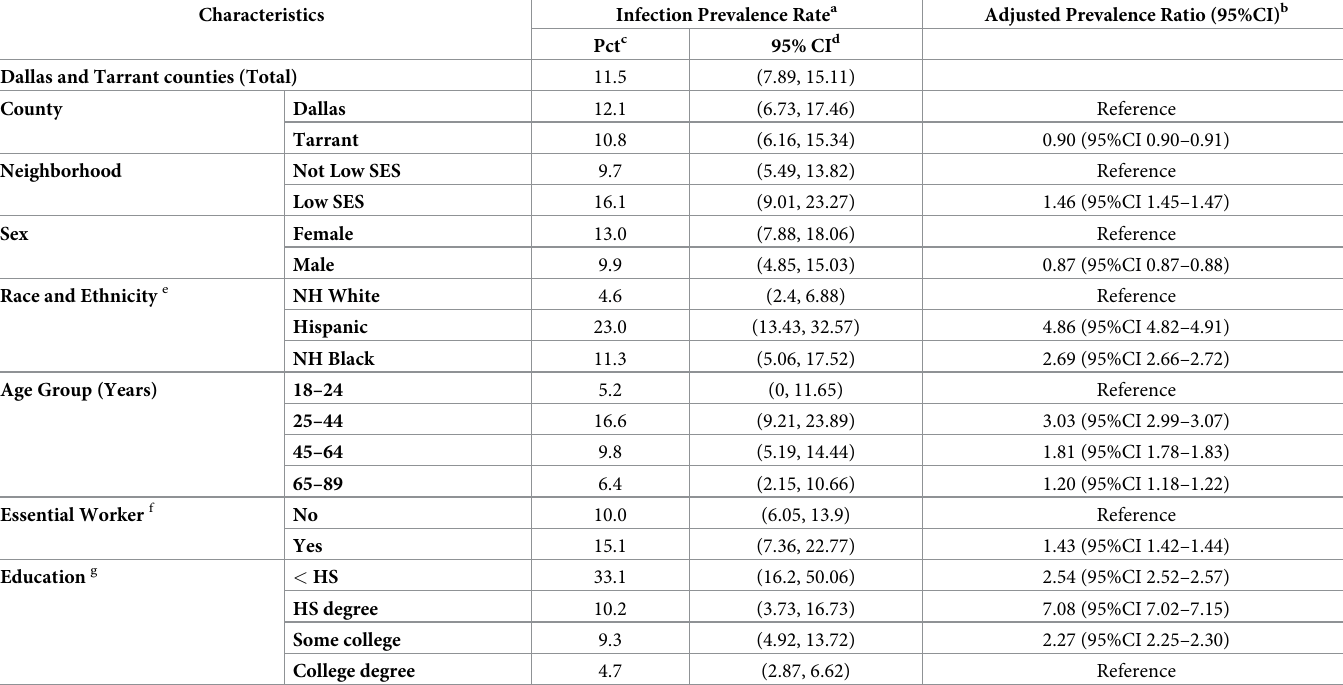
Table 2. Estimated prevalence of COVID-19 infection by select